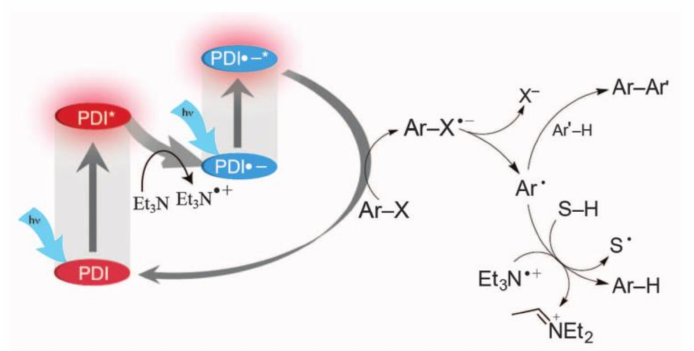
Figure 17. Organic proposed mechanism of reduction of aryl halides with PDI by consecutive visible light-induced electron transfer processes. Reprinted with permission from Ref. [19]. Copyright 2014, The American Association for the Advancement of